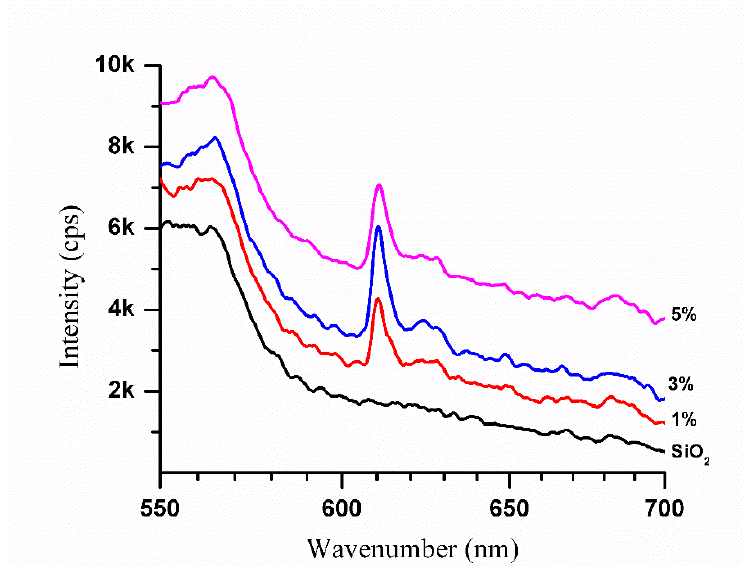
Figure 13. Photoluminescence emission spectra of pure SiO 2 and SiO 2 -Gd 2 O 3 :Eu 3+ (1%) nanoparticles at different europium ion concentrations (1, 3, and 5%). The spectra exhibit an intense band corre- sponding to the europium ion.